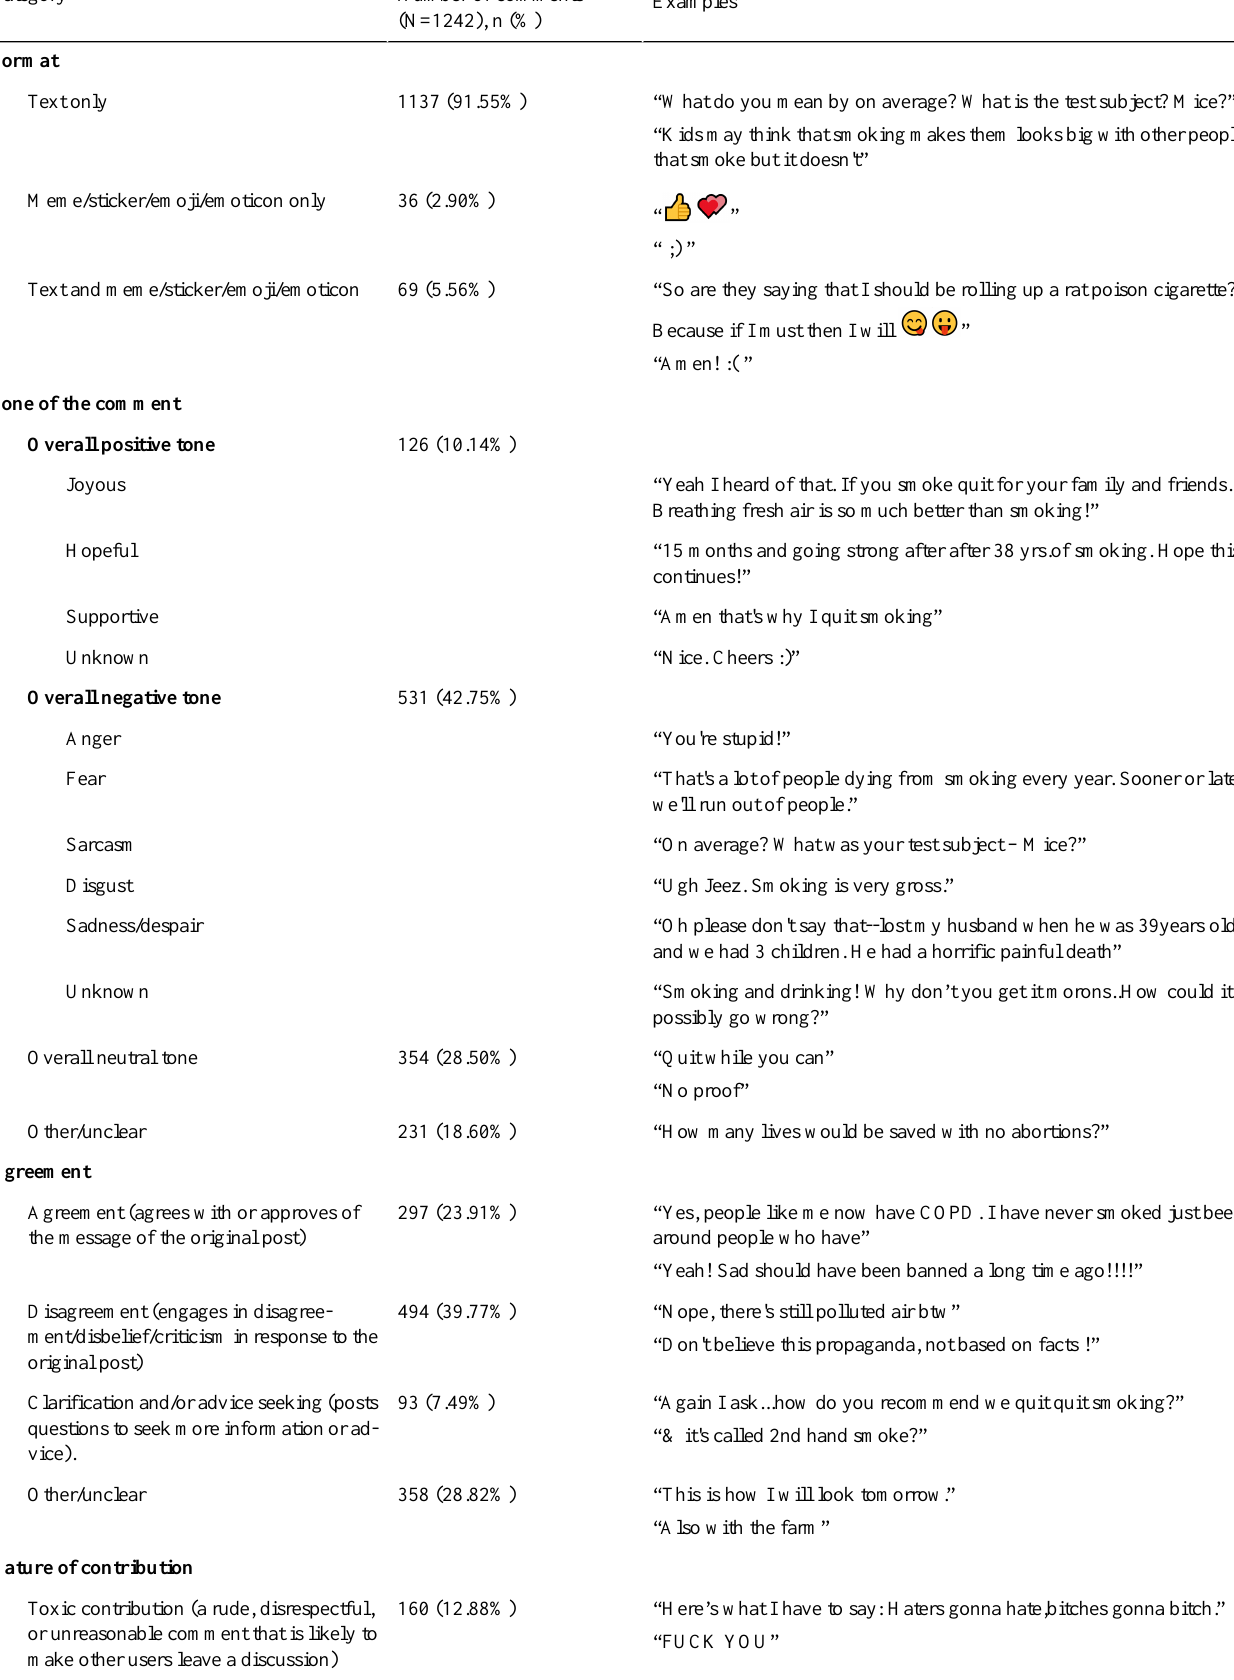
Table 1. Sample characteristics of comments collected from Twitter, Facebook, and Instagram in response to a tobacco prevention